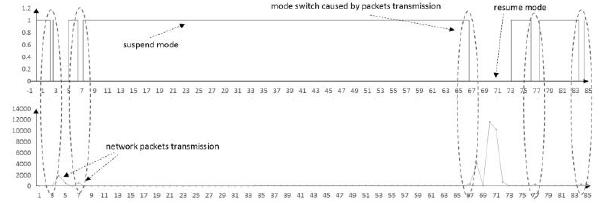
Fig. 2 . (b) Network transmission behavior impact on suspend/ Figure 3. Network transmission behavior impact on sus- resume mode switch pend/resume mode switch